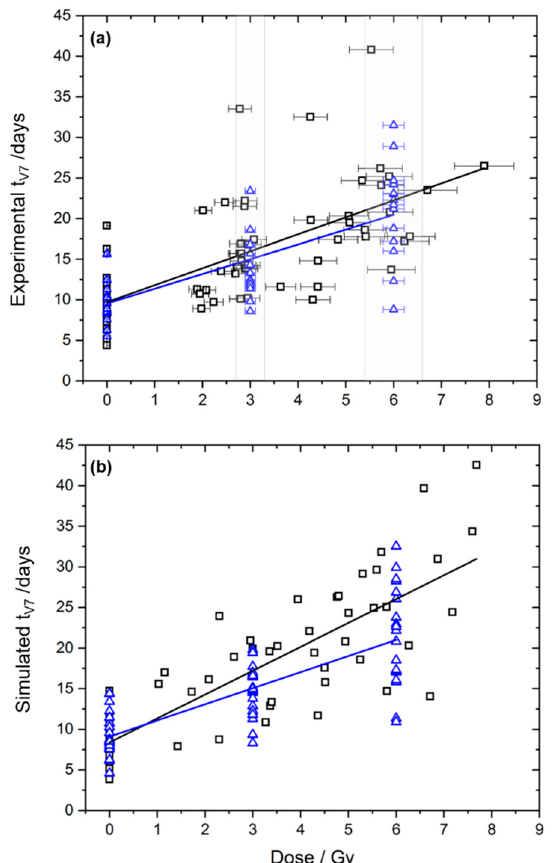
Figure 1. Experimental ( a ) and simulated ( b ) tumour growth data, i.e., time to achieve sevenfold relative volume increase ( t V7 ), and the corresponding linear regressions for treatment with laser-driven (black squares) and Linac electrons (blue triangles). For the experimental data, the dose region useable for conventional analysis is marked in grey. Therefore, black squares outside the grey area mark mice, which were not included in the conventional analysis.